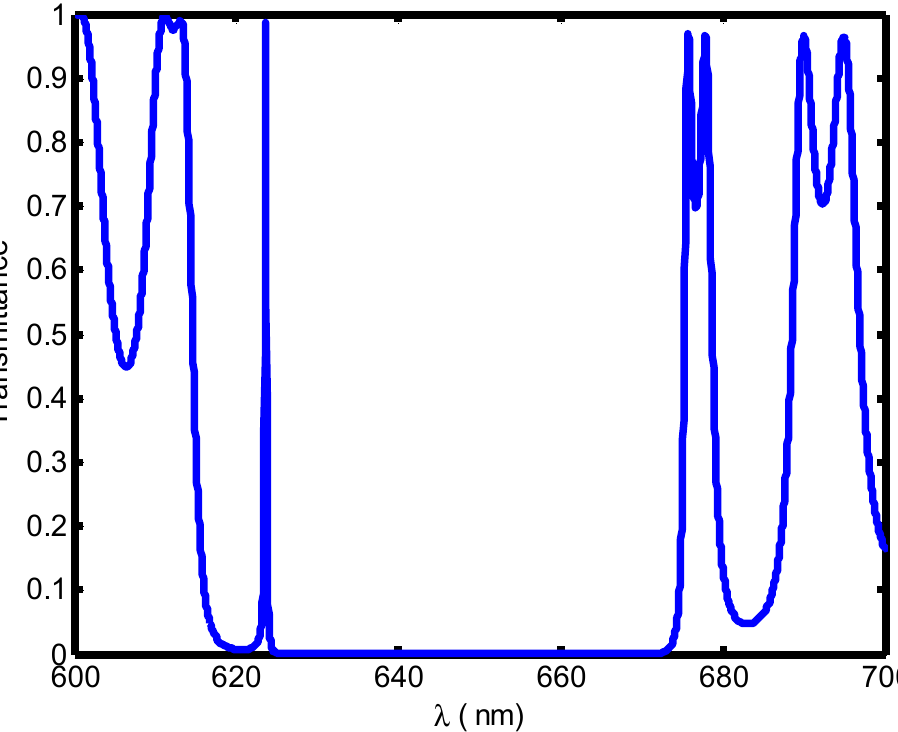
Figure 3. Transmission spectra of proposed biosensor loaded with water sample corresponding to cavity of thickness dd = 300 nm at normal